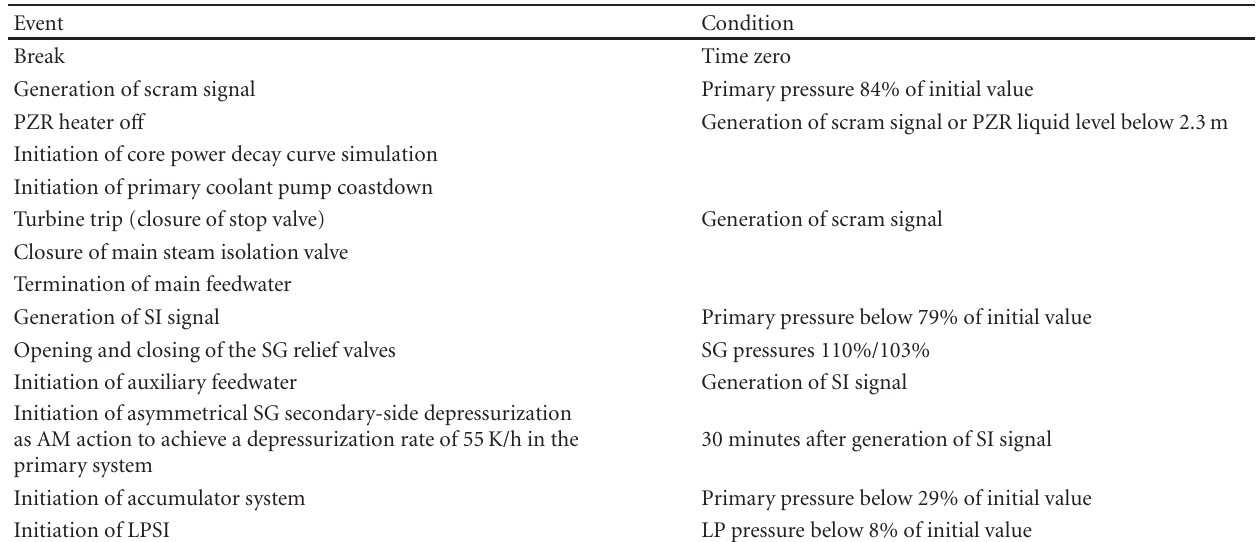
Table 4: Control logic of Test 6-2 [9].